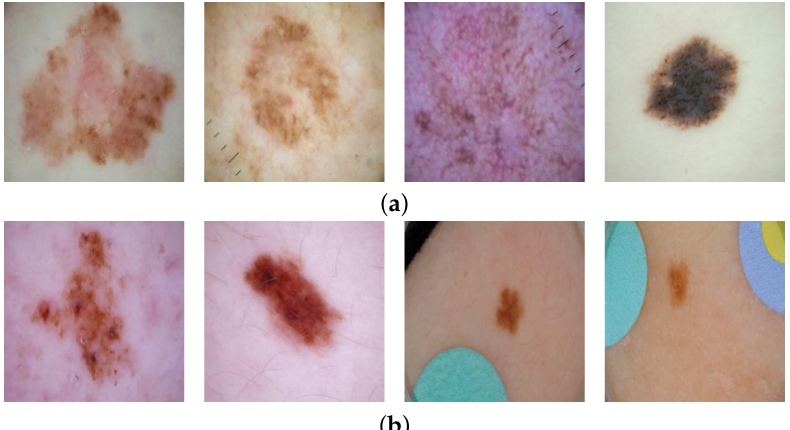
Figure 1. Examples from the ISIC dataset. Half of the benign lesion images include a coloured patch in the image which could cause a classifier to rely on these patches. ( a ) Malignant, no images with coloured patches in the dataset; ( b ) Benign, approximately half of the images show coloured